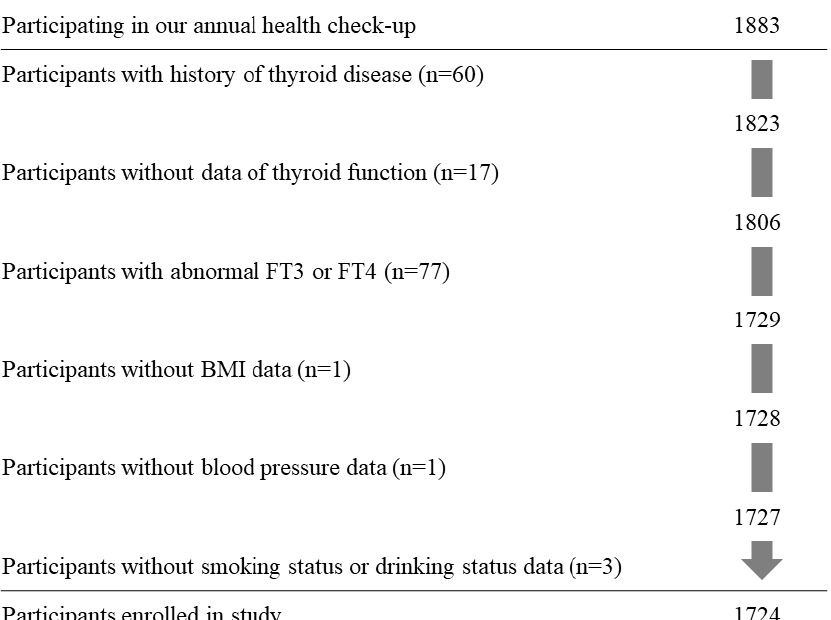
Figure 1. Demographic of study population. FT3: free triiodothyronine. FT4: free thyroxine. BMI: body mass index.